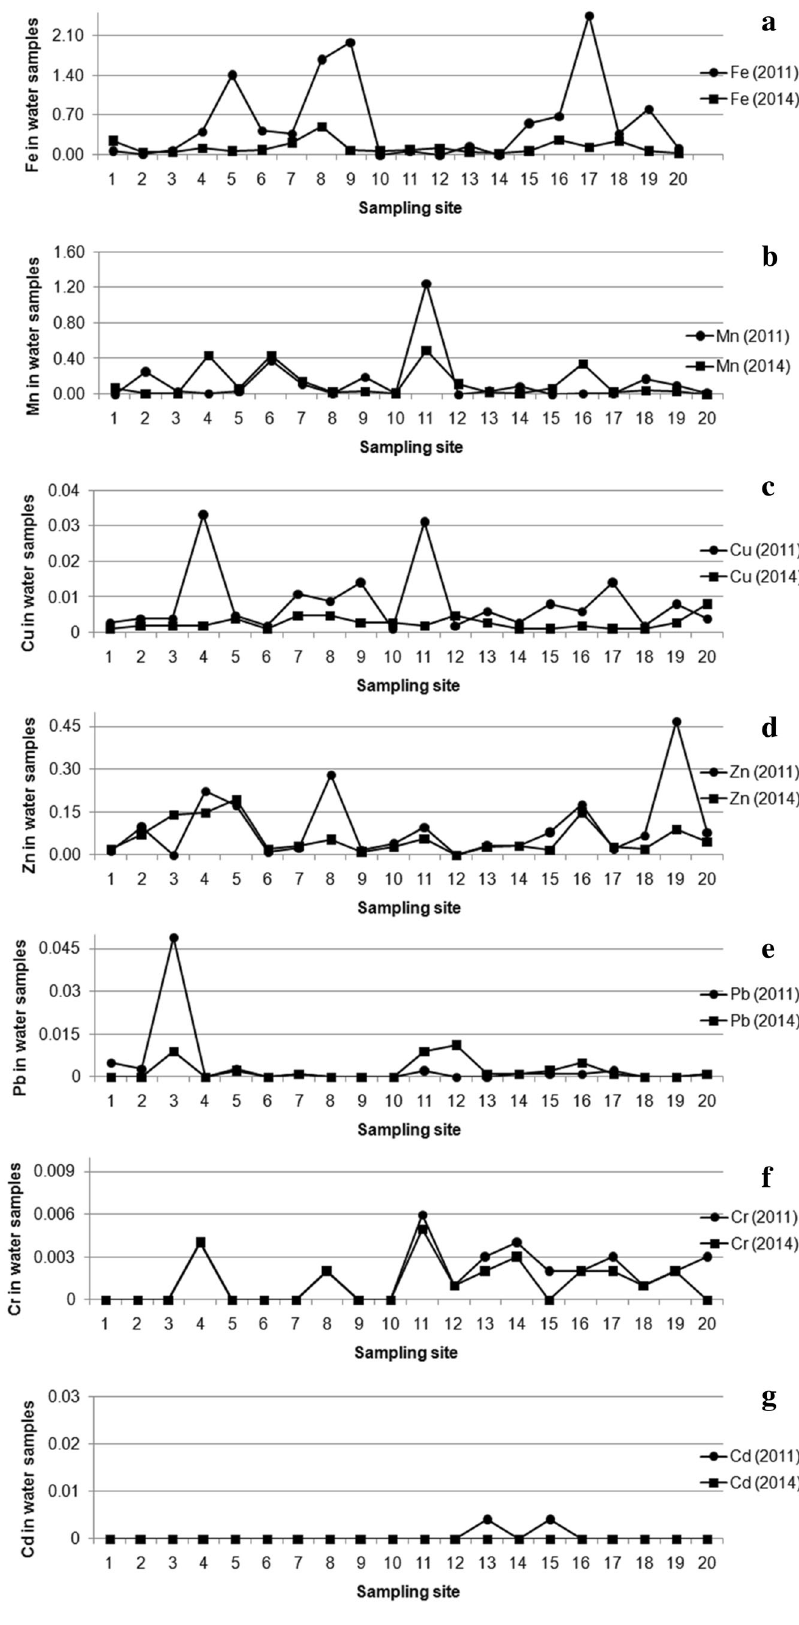
Fig. 3 Variation